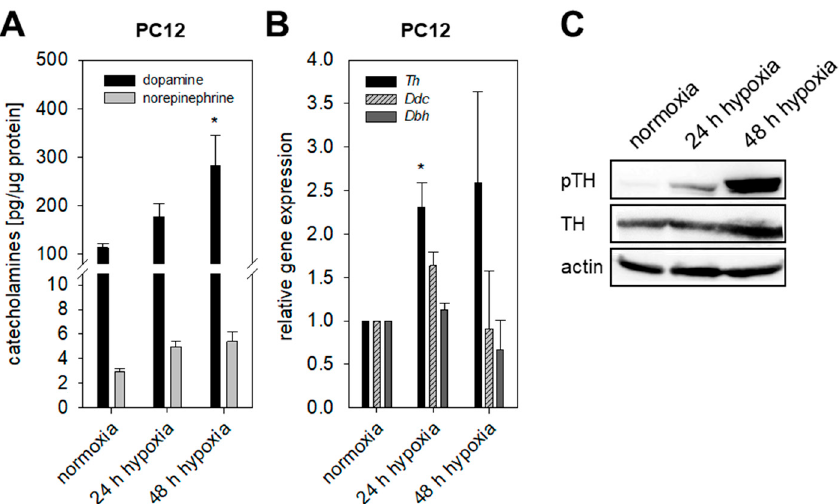
Figure 3. Impact of extrinsic hypoxia in presence of Hif1 α and Hif2 α . ( A ) Cellular catecholamines in PC12 cells in dependence of hypoxia. Presence of Hif1 α and Hif2 α led to an increase of dopamine within the cells. Three independent experiments ( n = 6–9). Mean ± SEM. ANOVA and Bonferroni post hoc test comparison vs. normoxia, * p < 0.05. ( B ) Hypoxia resulted in a significant up-regulation of Th expression in PC12 cells under extrinsic hypoxia, whereas expression of Ddc and Dbh remained unaffected. Four independent experiments ( n = 4). Mean ± SEM. ANOVA and Bonferroni post hoc test comparison vs. normoxia, * p < 0.05. ( C ) Hypoxia further enhanced phosphorylation of TH at Ser40 investigated by Western blot analysis. Shown is a representative section out of three independent experiments.